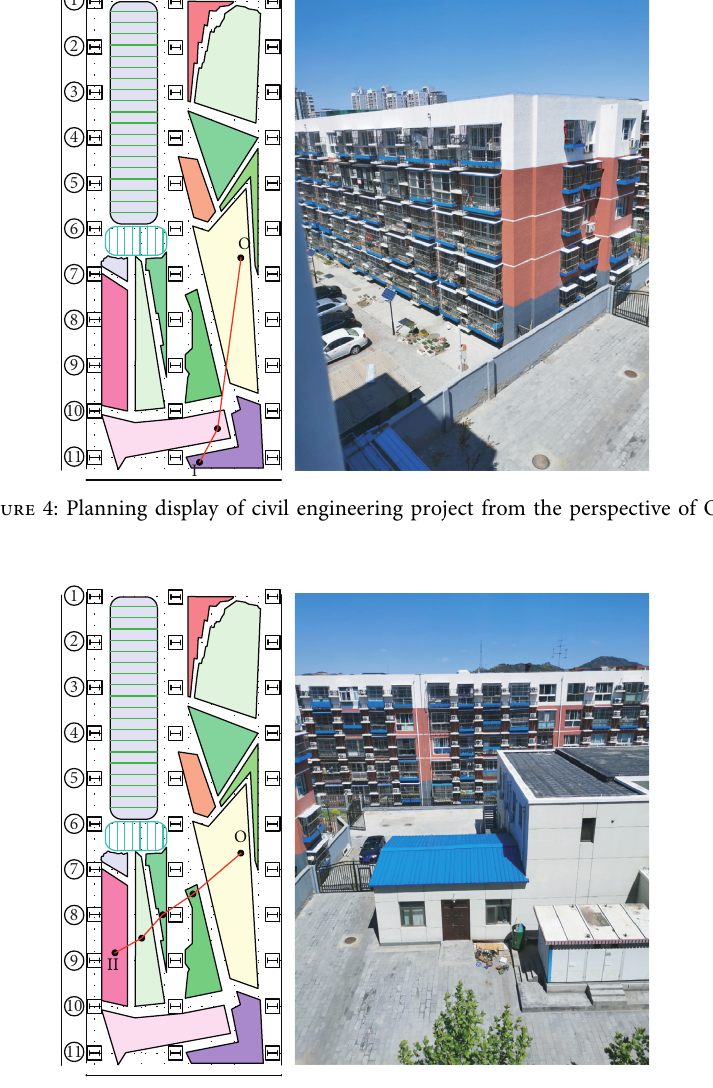
Figure 5: Planning display of civil engineering project from the perspective of